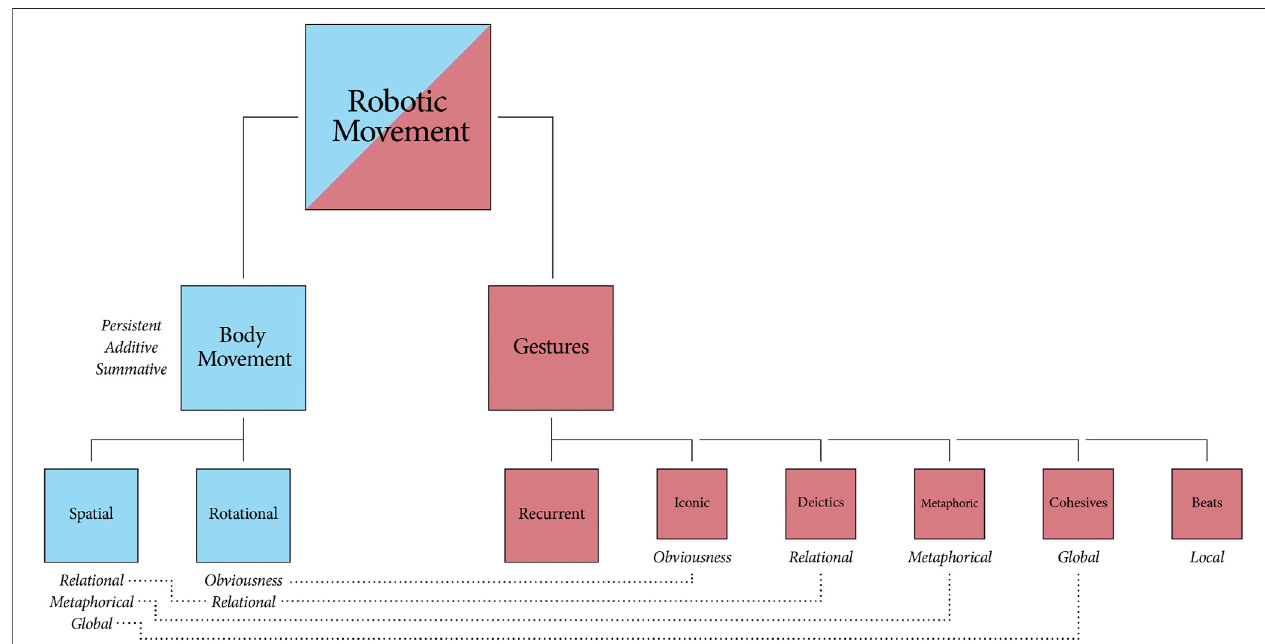
FIGURE1| Ataxonomyofroboticmovementsandtheirproperties.Nodestotheleftandrightdepictbroadtypesofroboticmovementandtheirspeci fi csub-types (rotational, spatial, iconic gestures, narrative beats, etc). Shared properties are indicated with horizontal connections (dashed lines).